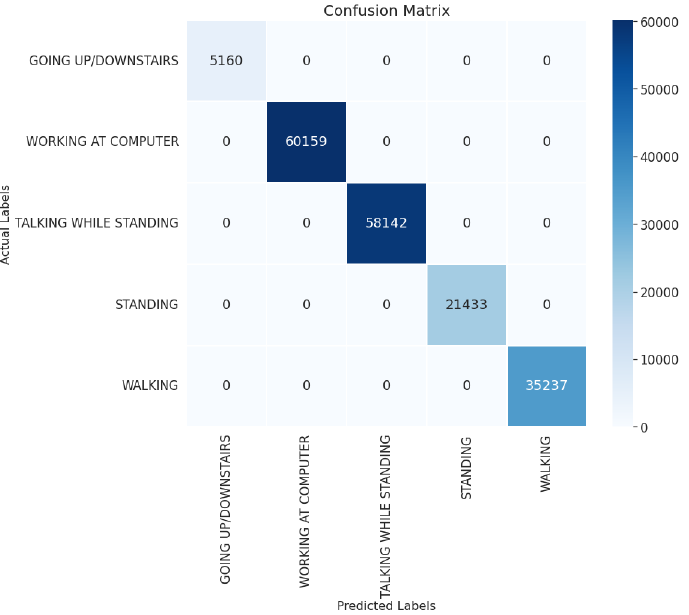
Figure 4. The confusion matrix of the 1D-CNN-BiLSTM model on the Single Accelerometer